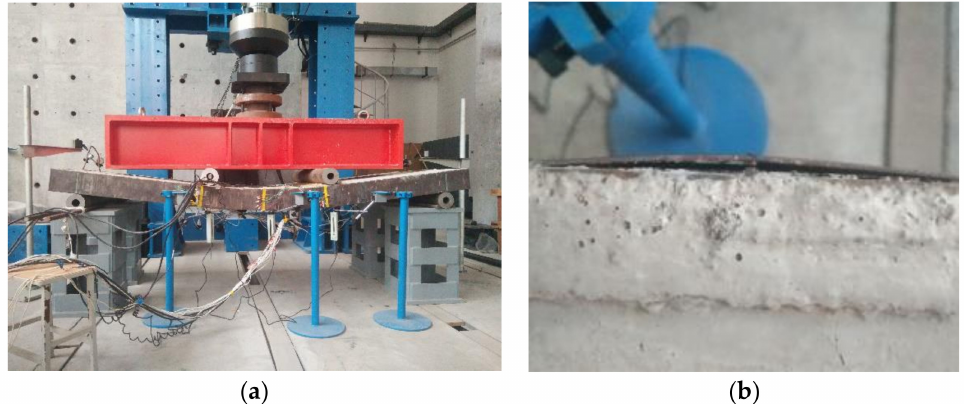
Figure 9. Failure characteristics of composite floor: ( a ) bending deformation of composite floor; ( b ) crack between steel plate and concrete on the side of the specimen.